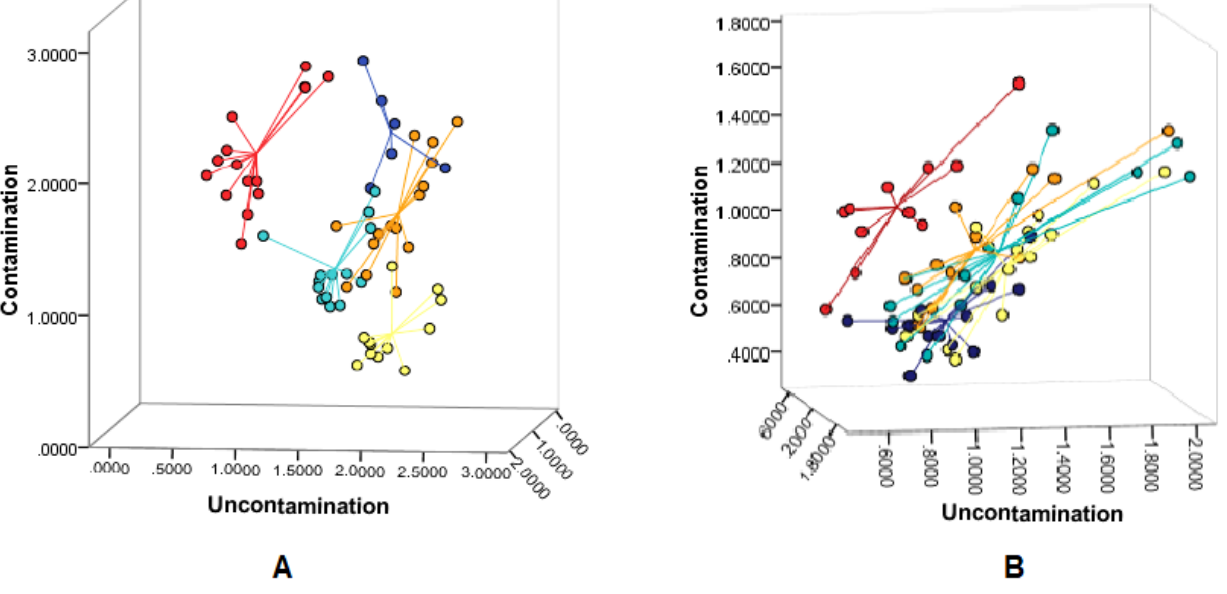
Figure 3. Distances between the centroids of soil samples ( A ) and pneumatophores ( B ); red — rural area; orange — market area; turquoise — port area; dark blue — hotel area; yellow — river mouth; no contamination — apparently very low plastic content in (rural) site (therefore, used as a reference), contamination — four anthropogenized locations visibly polluted with plastic.